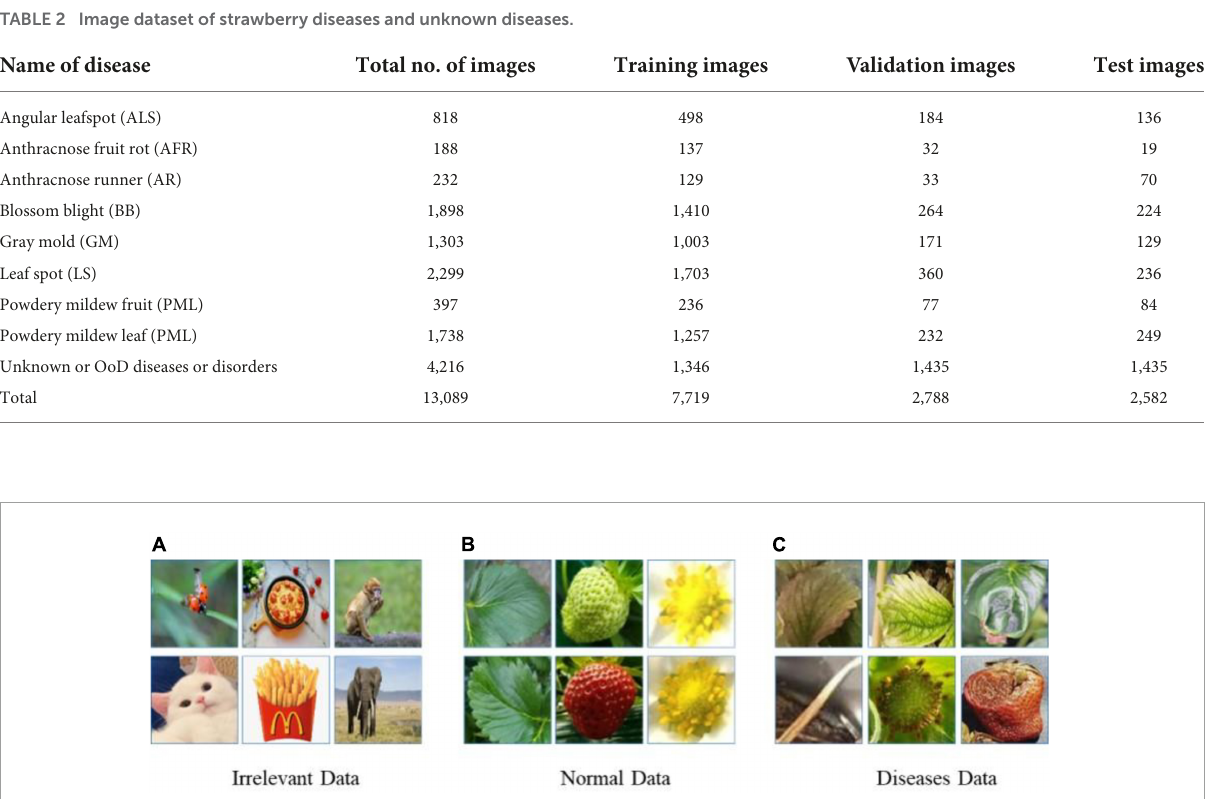
FIGURE7 Three types of Out-of-Distribution (OoD)